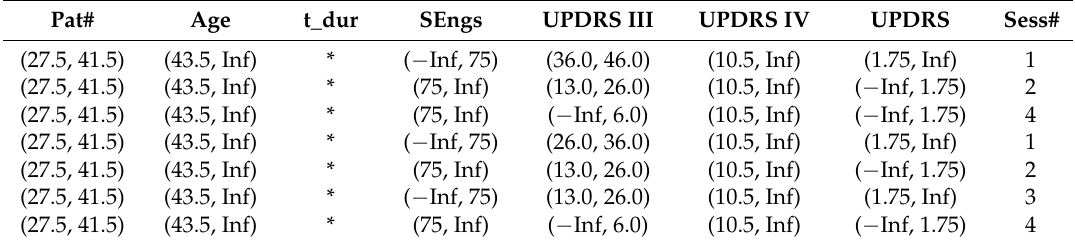
Table 5. Part of the decision discretized-table without eye movement measurements.